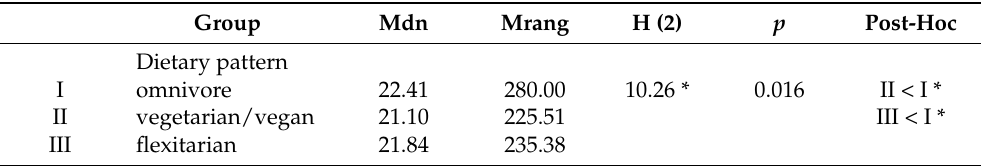
Table 5. Results of intergroup comparison using Kruskal–Wallis H test, according to BMI level and dietary pattern. Group Mdn Mrang H (2) p Post-Hoc Dietary pattern I omnivore 22.41 280.00 II vegetarian/vegan 21.10 225.51 III flexitarian 21.84 235.38